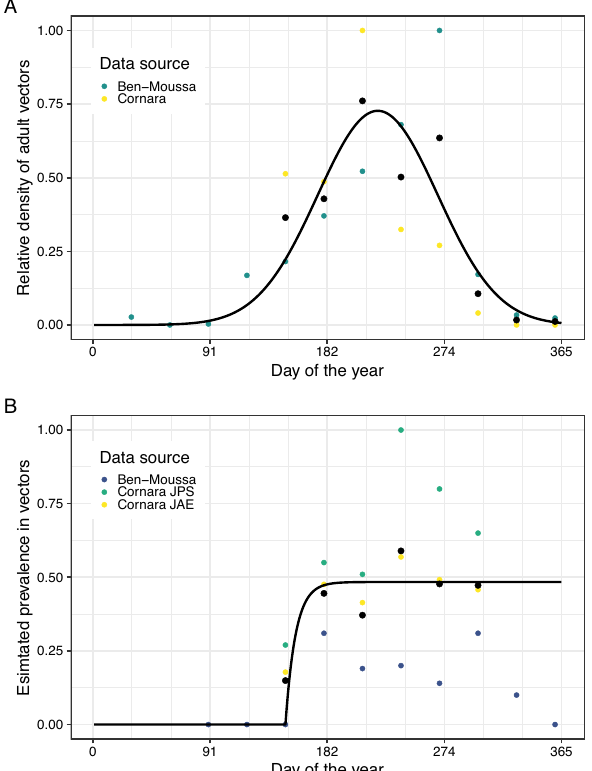
Figure 2. There is pronounced seasonal variability in the density of adult P. spumarius and the prevalence of X. fastidiosa infection amongst these. ( A ) Data suggest that adult P. spumarius are absent from January to March, and peak in density around August. This plot shows the modelled change in relative P. spumarius density over a year, fitted to data from two papers. The black dots show the mean density from both papers 20,28 . ( B ) Data suggest that the prevalence of X. fastidiosa infection in adult P. spumarius increases rapidly between June and July, to reach a steady peak for the rest of the year. This plot shows the modelled change in the prevalence of X. fastidiosa infection of P. spumarius over a year, fitted to data from three papers: “Cornara JPS” 28 , “Cornara JAE” 22 , and “Ben-Moussa” 20 . The black dots show the mean prevalence estimates from all three